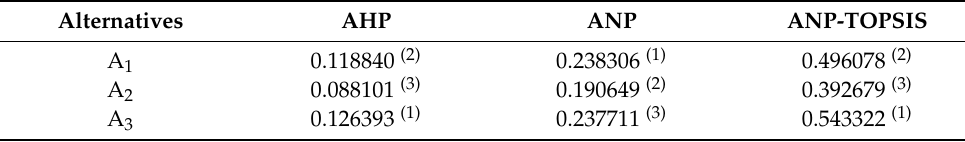
Table 12. The score of alternatives obtained from traditional AHP, ANP and hybrid ANP-TOPSIS models. (Note: superscript numbers represent the rank of the